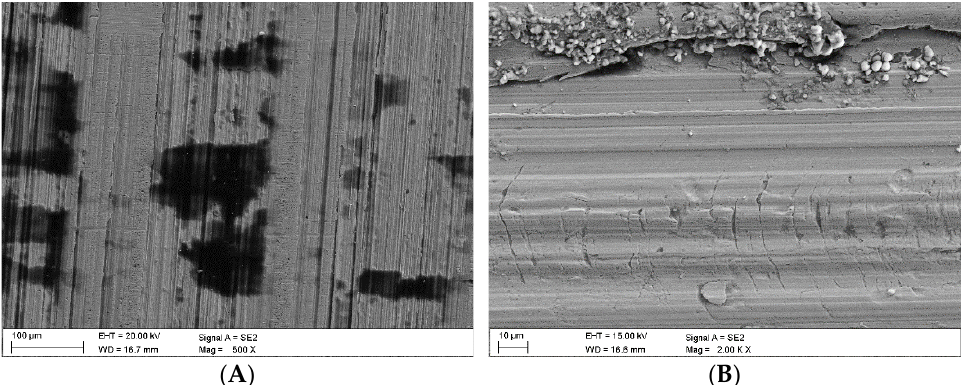
Figure 8. Coal_1; ( A )—coal abrasive material pressed into the irregularities caused by the grinding wheel action, ( B )—delamination damage and traces of fatigue cracks.